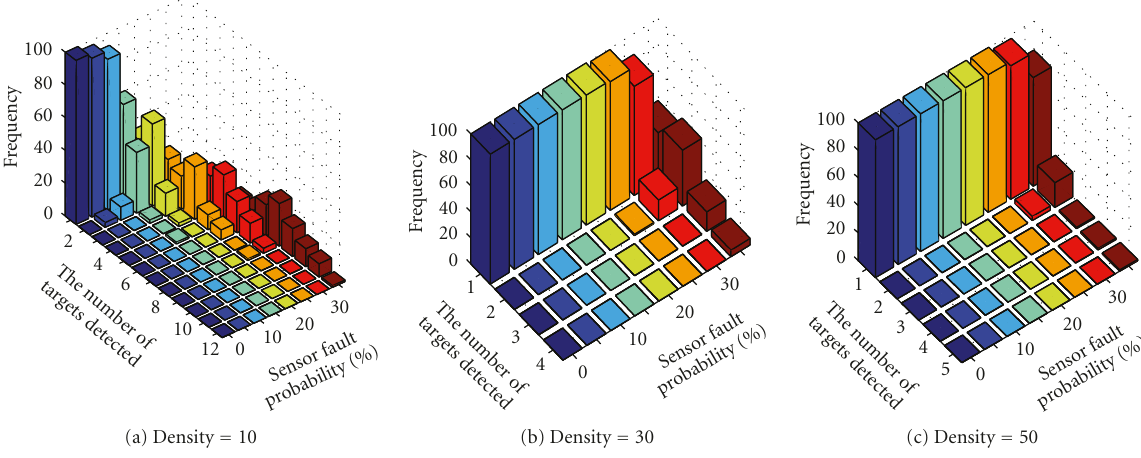
Figure 3: The number of targets detected when one target is deployed. Here, T = 9 and density = 10,30,50, respectively.